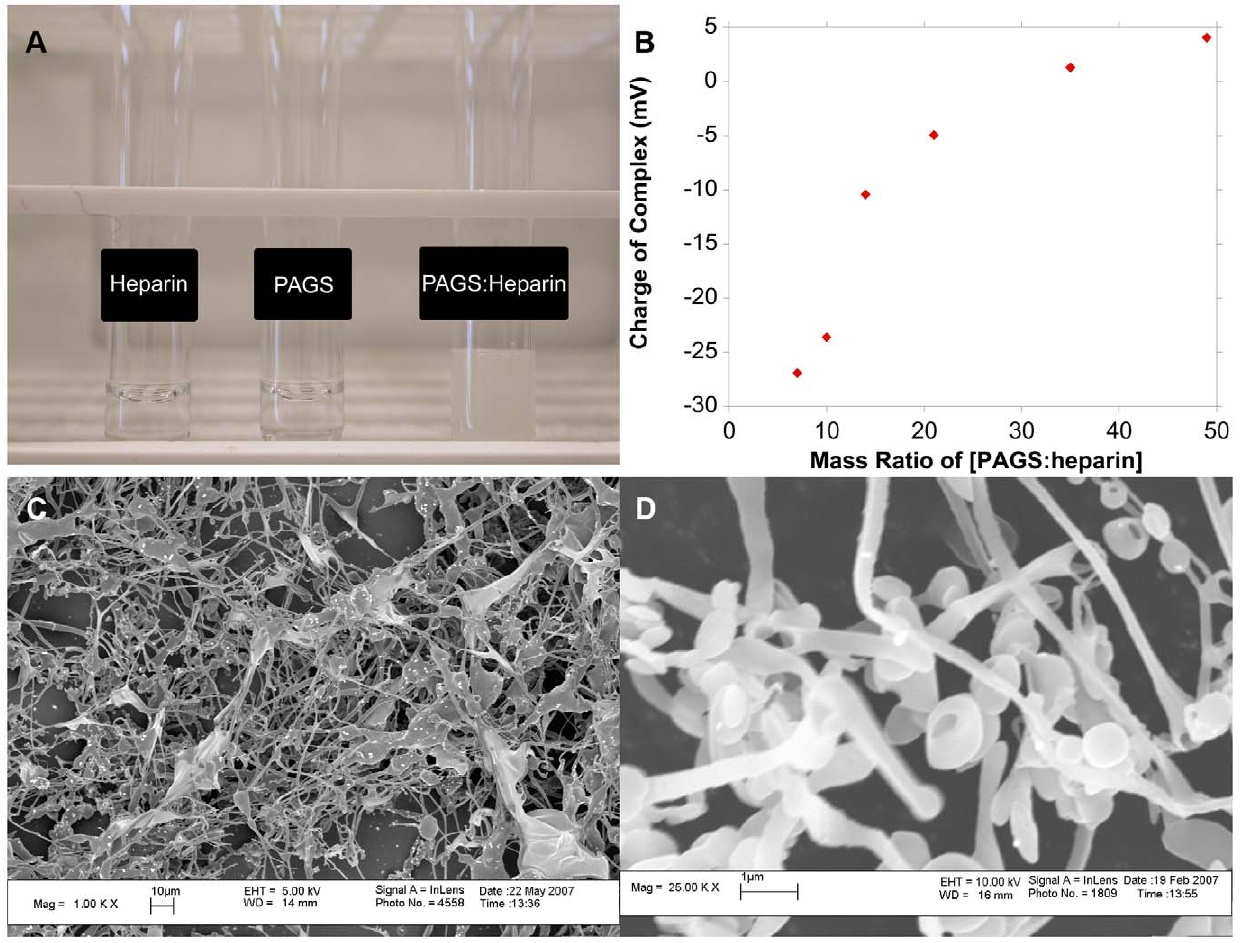
Figure 2. The interaction between PAGS and heparin. [A] The binding of PAGS and heparin resulted in a white precipitate when combined in an aqueous solution. [B] The titration of heparin using PAGS as monitored by zeta potential measurements. The complex was nearly neutral at a 35/1 mass ratio of PAGS/heparin. [C] SEM images revealed the [PAGS:heparin] complexes as a matrix composed of fibers and sheets, and beads (1000 6 ). [D] Higher magnification (25000 6 ) revealed that many of the fiber are sub-micron in diameter and the beads were in fact rings.